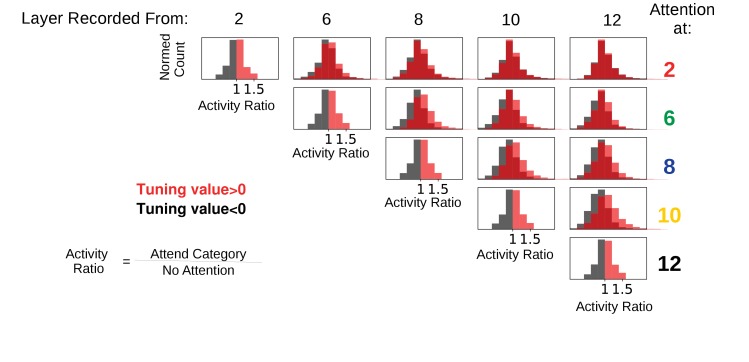
Feature-based attention at one layer often suppresses activity of the attended features at later layers.Activity ratios are shown for when attention is applied (according to tuning) at various layers individually and activity is recorded from that layer and later layers. In all cases, the category attended was the same as the one present in the input image (standard ImageNet images used to ensure that these results are not influenced by the presence of other category features in the input). Histograms are of ratios of feature map activity when attention is applied to the category divided by activity when no attention is applied, split according to whether the feature map prefers (red) or does not prefer (black) the attended category. In many cases, feature maps that prefer the attended category have activity ratios less than one, indicating that attention at a lower layer decreases the activity of feature maps that prefer the attended category. The misalignment between lower and later layers is starker the larger the distance between the attended and recorded layers. For example, when looking at layer 12, attention applied at layer two appears to increase and decrease feature map activity equally, without respect to category preference. This demonstrates the ability of attention at a lower layer to change activity in ways opposite to the effects of attention at the recorded layer.